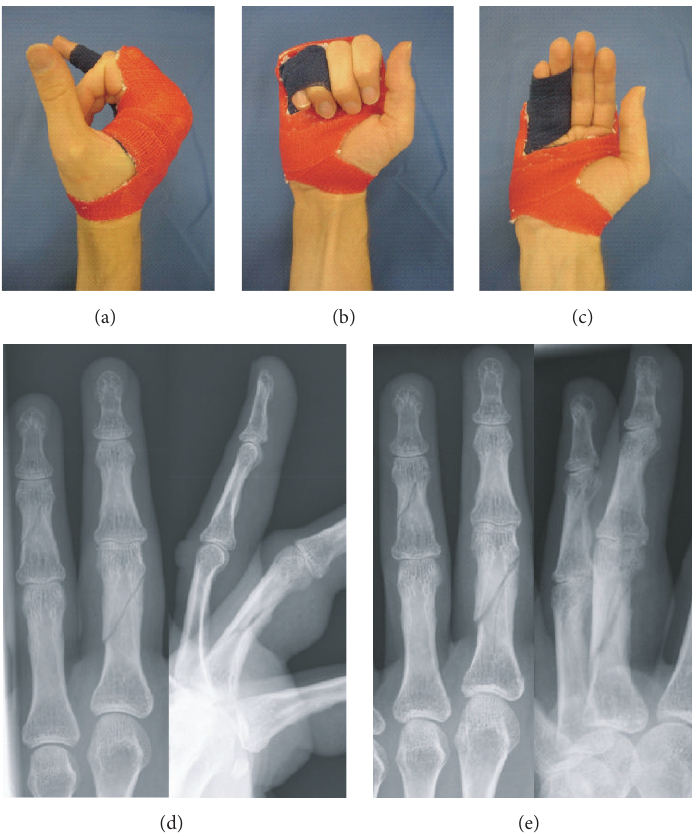
Figure 5: Dynamic finger orthoses with taping: (a) radial, (b) dorsoradial, and (c) palmar view; case sample: nondisplaced 4th proximal phalangeal/5th middle phalangeal fracture, (d) X-ray on admission and (e) at 5 weeks (DASH analysis of case series: 𝑛 = 27 ; score-mean = 33.30 ± 9.99 SD; DASH follow-up interval (weeks): 9.08 ± 2.33